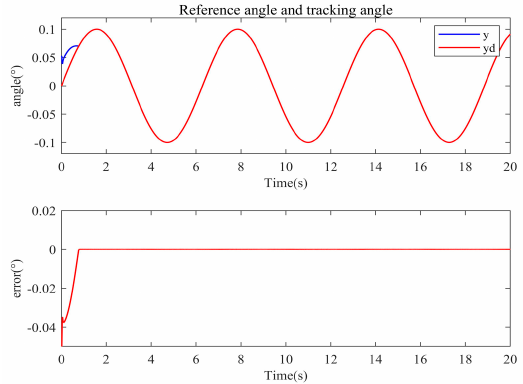
Figure 13. Angle tracking curve and error curve.